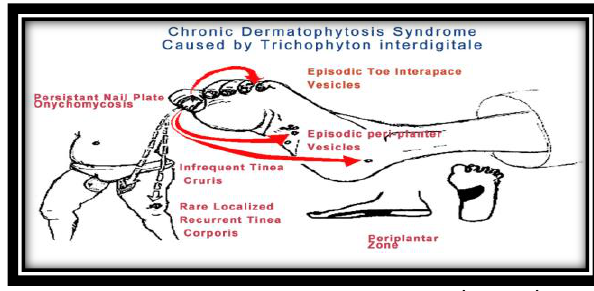
4. Acute Ulcerative Type. Rampant bacterial co-infection, most